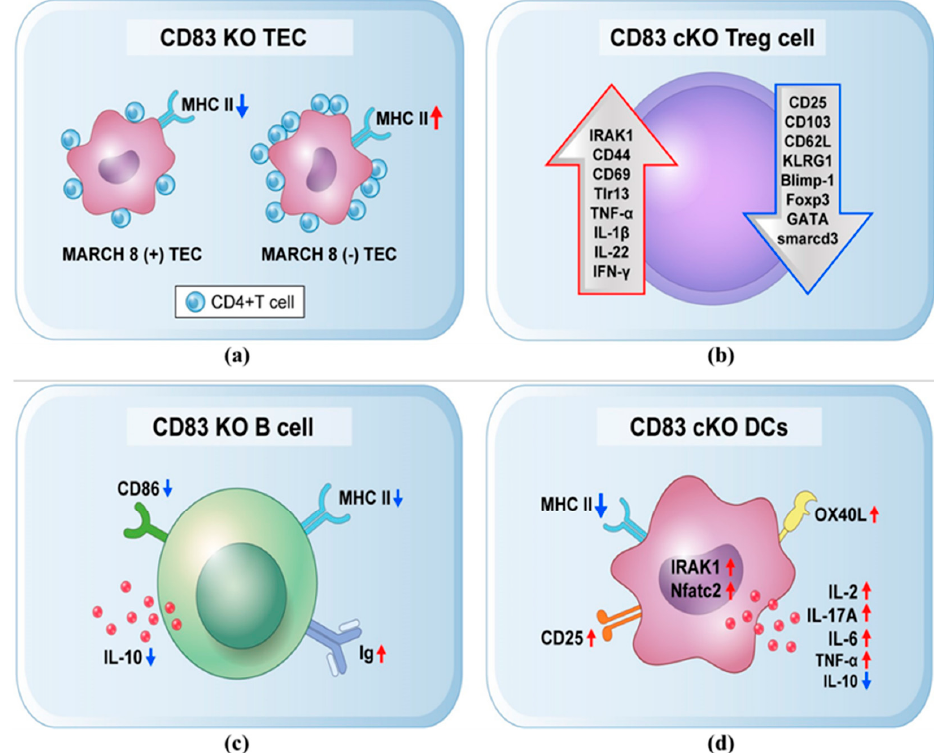
Figure 1. CD83 knockout (KO) mice model displayed abnormal tolerance. ( a ) CD83 KO TEC showed a strongly decreased number of CD4+ T cells and deletion of MARCH 8 in CD83KO TEC restored CD4+ T cells. ( b ) In CD83 cKO mice, CD83 is only ablated in Treg cells, and expression of Treg-specific maturation biomarkers (CD25, CD103, CD62L, or KLRG1) and transcriptional factors (Blimp-1, Foxp3, GATA, and Smarcd 3) are reduced. Signaling pathway (IRAK1), inflammatory cytokines (TNF- α , IL-1 β , IFN- γ , IL-22), and other biomarkers (CD44, CD69, Tlr13) were present at high levels. ( c ) CD83 KO B cells have reduced IL-10, MHC II, CD86 expression levels, and increased Ig levels. ( d ) CD83 KO DCs expressed higher levels of costimulatory molecules (OX40L, CD25) and transcription factors (IRAK1, Nfatc2) and significantly more cytokines (IL-2, IL-17A, IL-6, TNF- α ) were secreted. Overall, CD83 expression is essential for ongoing immunological responses.